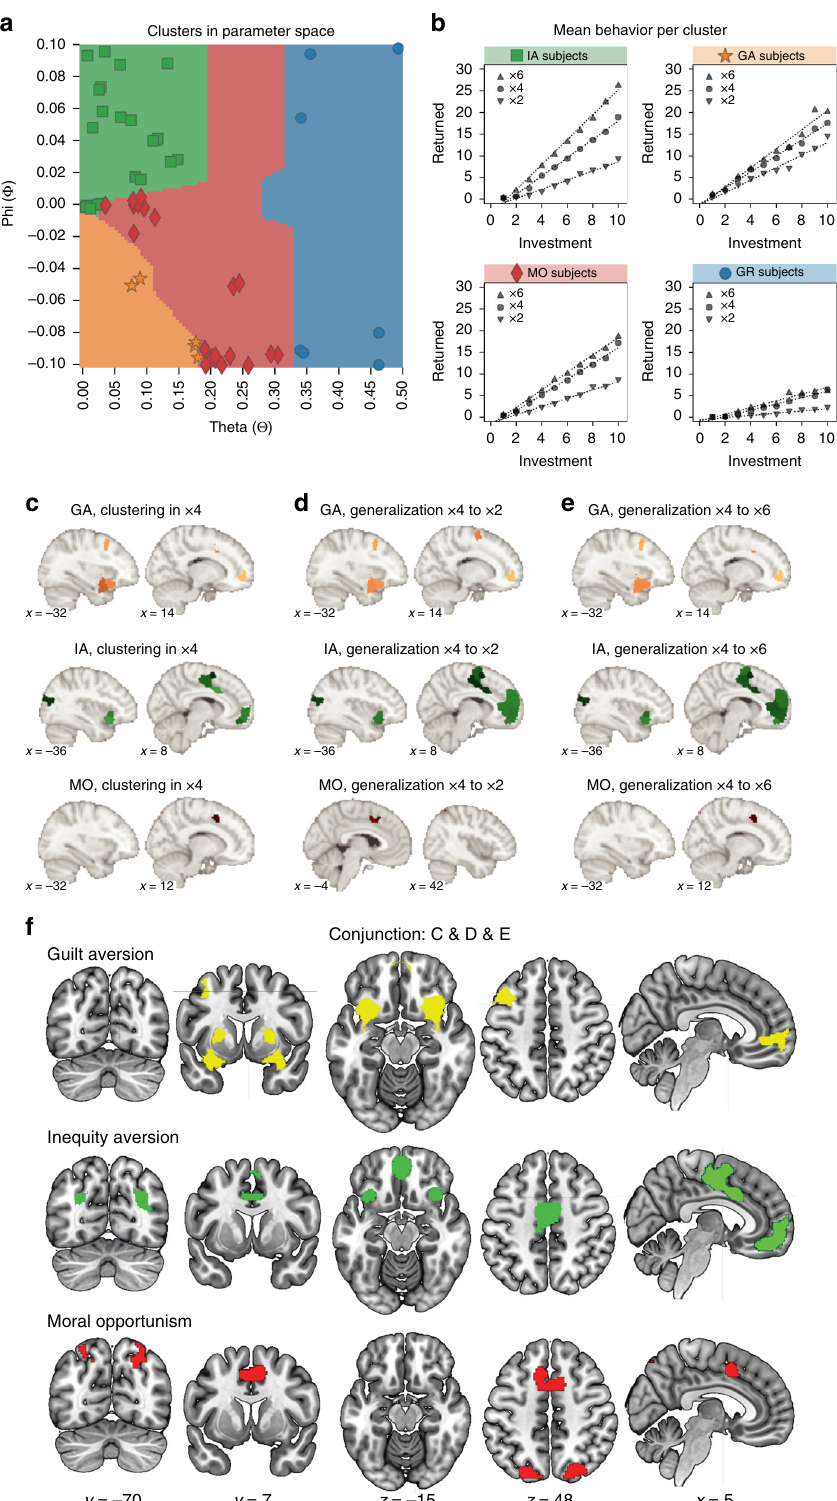
Fig. 4 Strategy-linked activity patterns replicate over participants and contexts. a Model-driven clustering of the parameter space by moral strategy based on similarity between model simulations. b Mean reciprocity behavior in each of the four strategy groups re fl ects the theoretical predictions of IA, GA, MO, and GR. IA inequity-averse, GA guilt-averse, MO morally opportunistic, GR greedy. c Multi-voxel activity patterns that replicate over subjects within moral strategy group in the ×4 condition (i.e., patterns generalize over subjects within group). d Parcels where strategy-speci fi c ×4 activity patterns generalize across subjects to ×2. e Parcels where strategy-speci fi c ×4 activity patterns generalize across subjects to ×6. f Conjunction of c , d , and e . Activity patterns in these parcels clustered within the respective strategy group in the x4 condition, and generalized to ×2 and